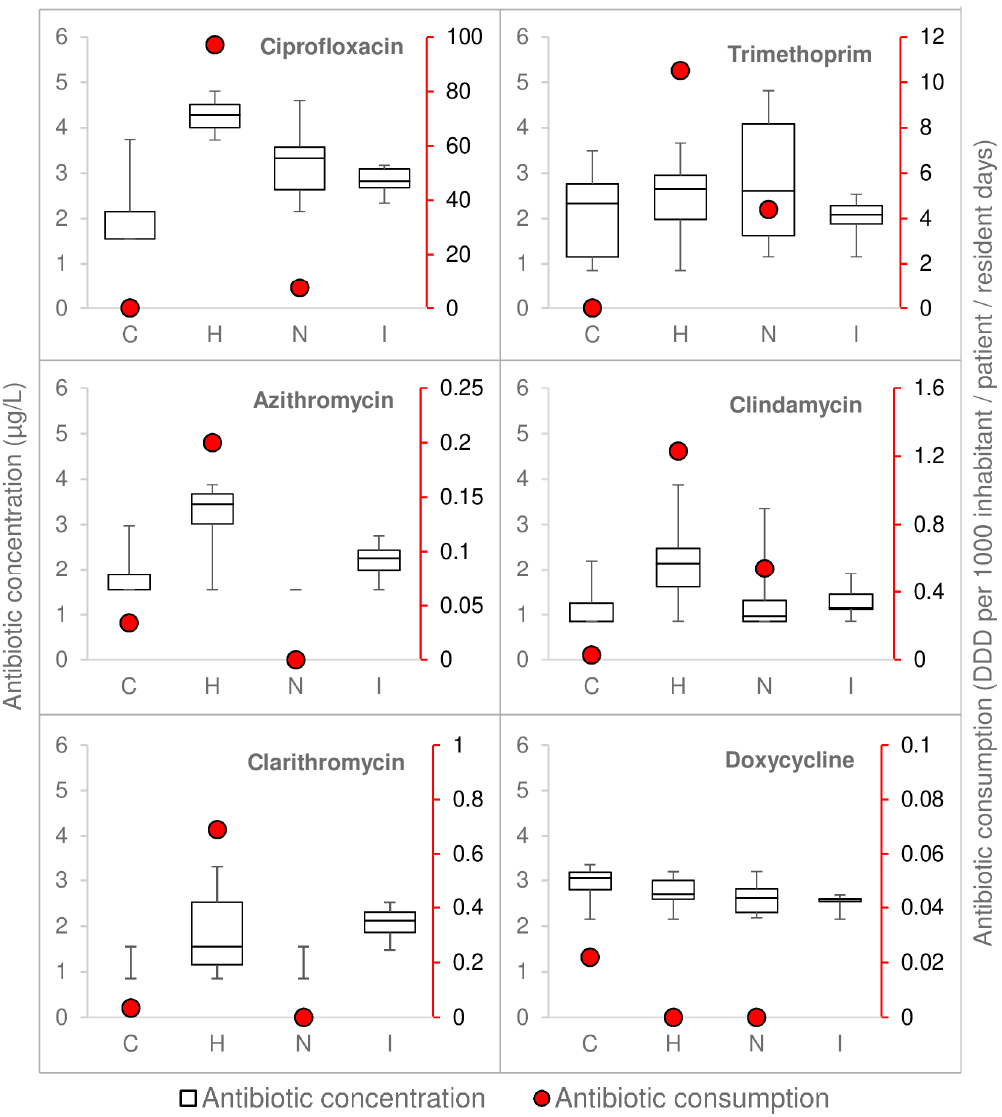
Figure 1. Antimicrobial consumption versus the measured concentrations. The red dots display the antimicrobial consumption, and the boxplots show the antimicrobial concentration measured in the wastewater. C = community, H = hospital, N = nursing home, I = influent. The antimicrobial concentrations measured in community (azithromycin, clindamycin, and clarithromycin) and nursing home wastewater (azithromycin and clarithromycin) are not shown as these locations contained less than five samples with decent measurements.